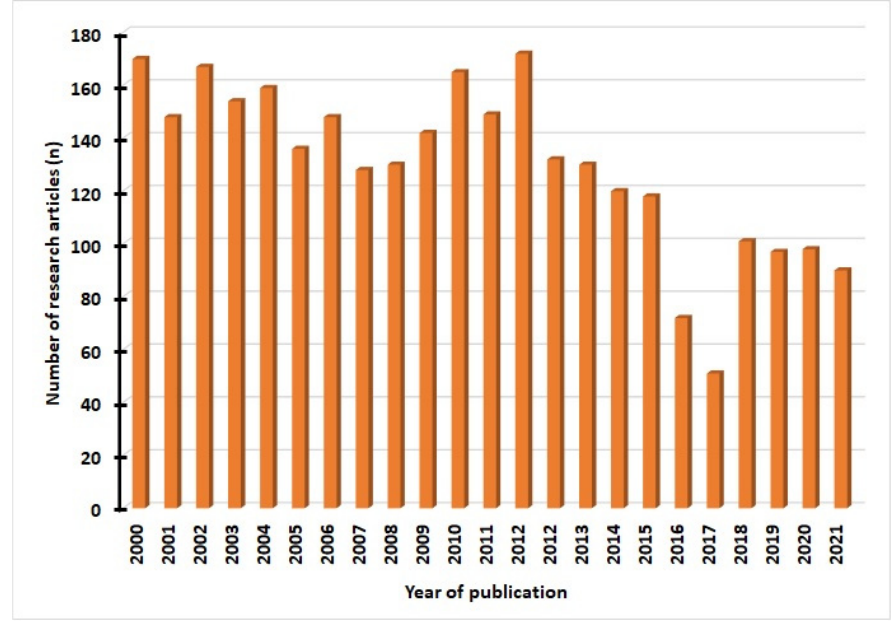
Figure 2. The number of research publications in antimicrobial resistance from 2000 to 2021.